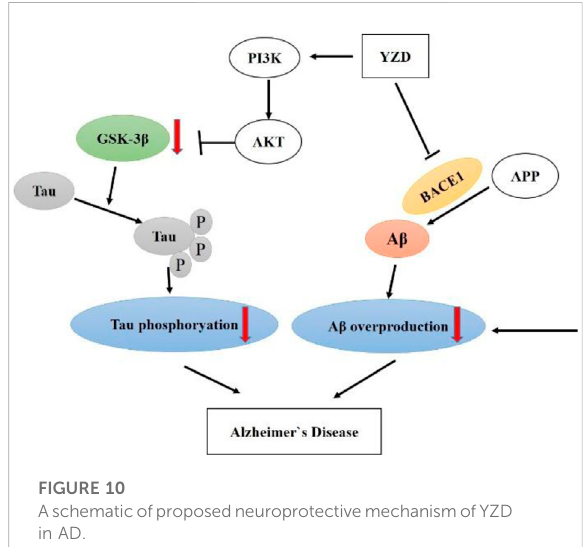
FIGURE 10 AschematicofproposedneuroprotectivemechanismofYZD in